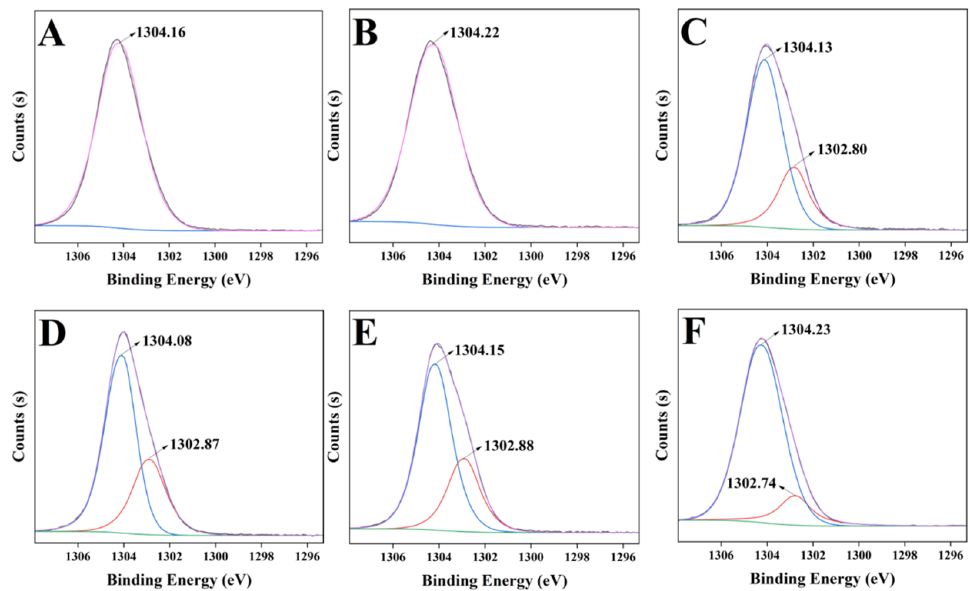
Figure 9. Mg1s XPS spectra of clean serpentine surface ( A ) and the serpentine surfaces interacted